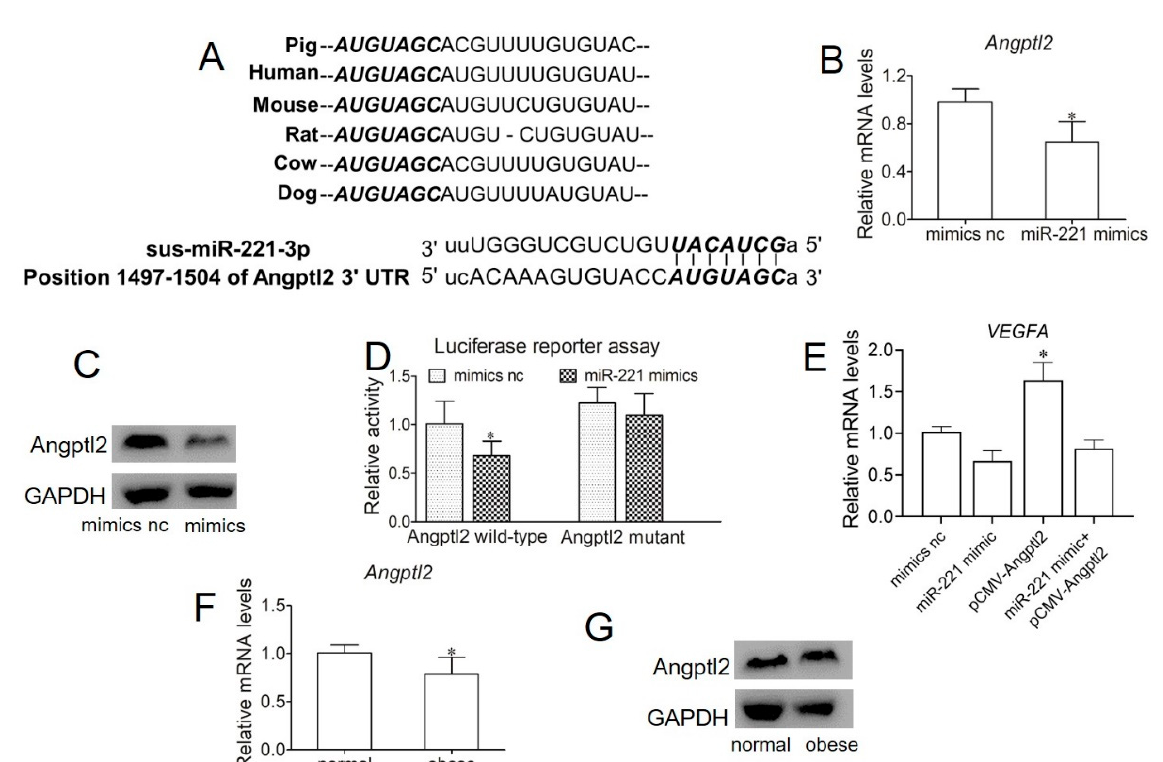
Figure 5. miR-221 impairs angiogenesis in endothelial cells by targeting Angptl2. ( A ) The sequences of sus-miR-221-3p and its predicted binding sites position of Angptl2 3 ′ UTR using miRbase, miRanda, and TargetScan. ( B ) qPCR was performed to detect the mRNA expression of Angptl2 after transfection with miR-221 inhibitor or miR-221 mimic. ( C ) Western blotting was performed to detect the protein expression of Angptl2 after transfection with miR-221 inhibitor or miR-221 mimic. ( D ) A dual-luciferase reporter assay was performed in 293T cells. ( E ) Angptl2 overexpression attenuated the suppressive function of miR-221-mediated angiogenesis in endothelial cells. ( F ) qPCR was performed to detect the mRNA expression of Angptl2 after incubation with exosomes from normal or obese sows. ( G ) Western blotting was performed to detect the protein expression of Angptl2 after incubation with exosomes from normal or obese sows. Values are means ± SD (n = 6 preparative replicates). * p < 0.05.